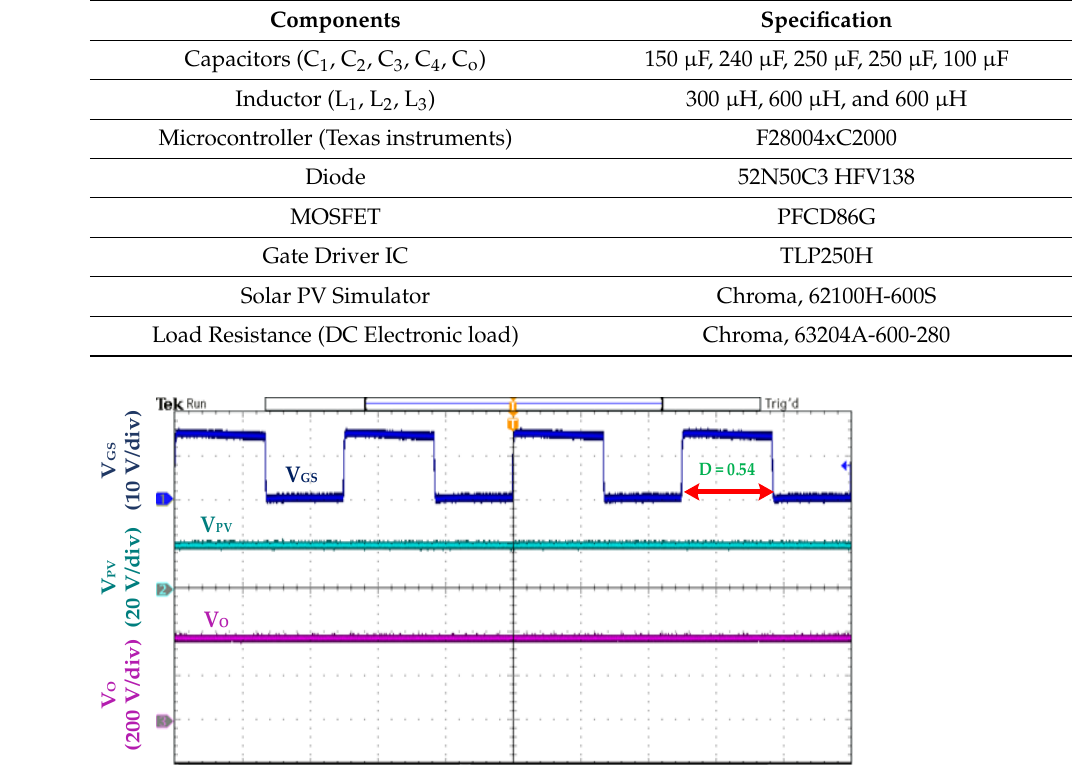
Table 3. The component specifications used in the hardware prototype of the proposed converter.